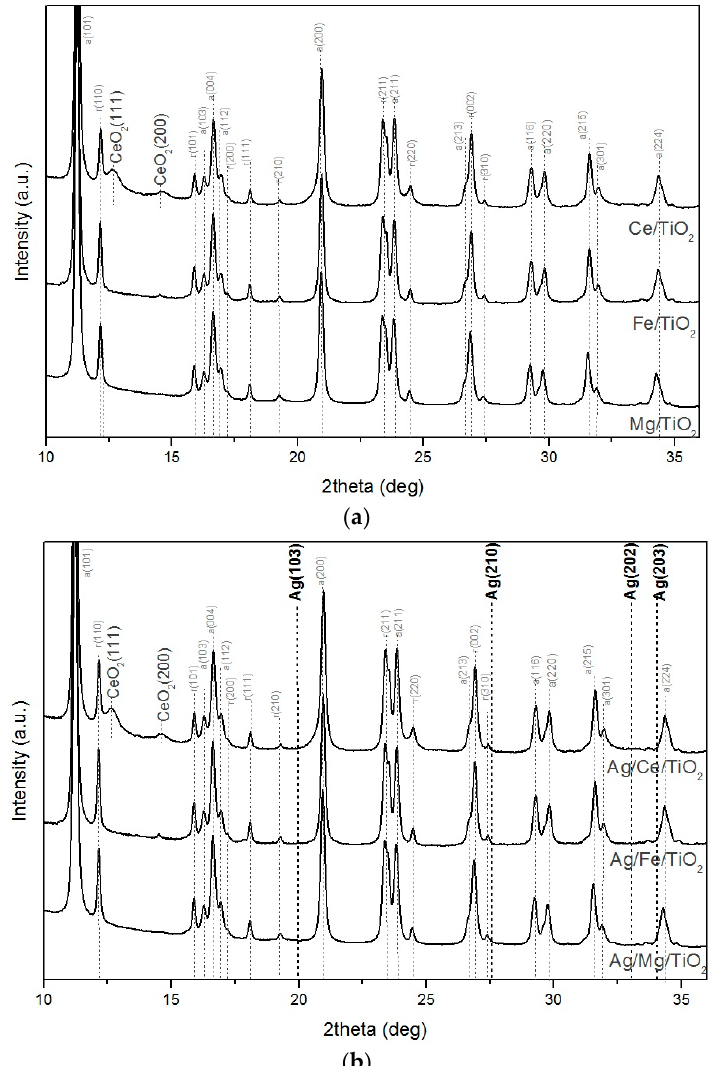
Figure 3. The SR-XRD patterns for the supports ( a ) and catalysts treated in H 2 flow at 300 °C for 1 h ( b ).